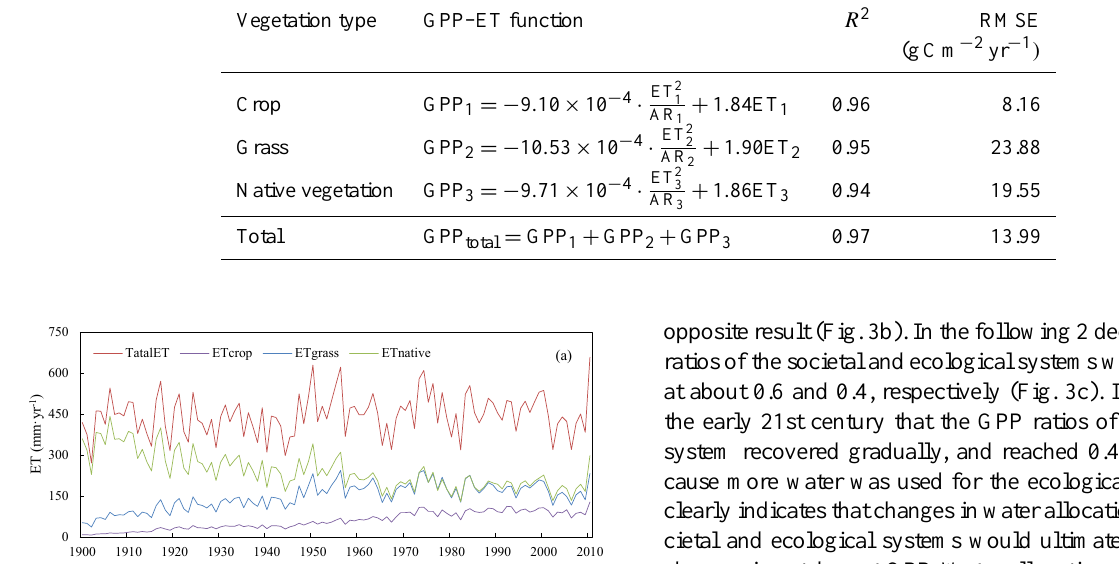
Table 1. The results and accuracy of GPP in the MDB obtained with the optimization method. Vegetation type